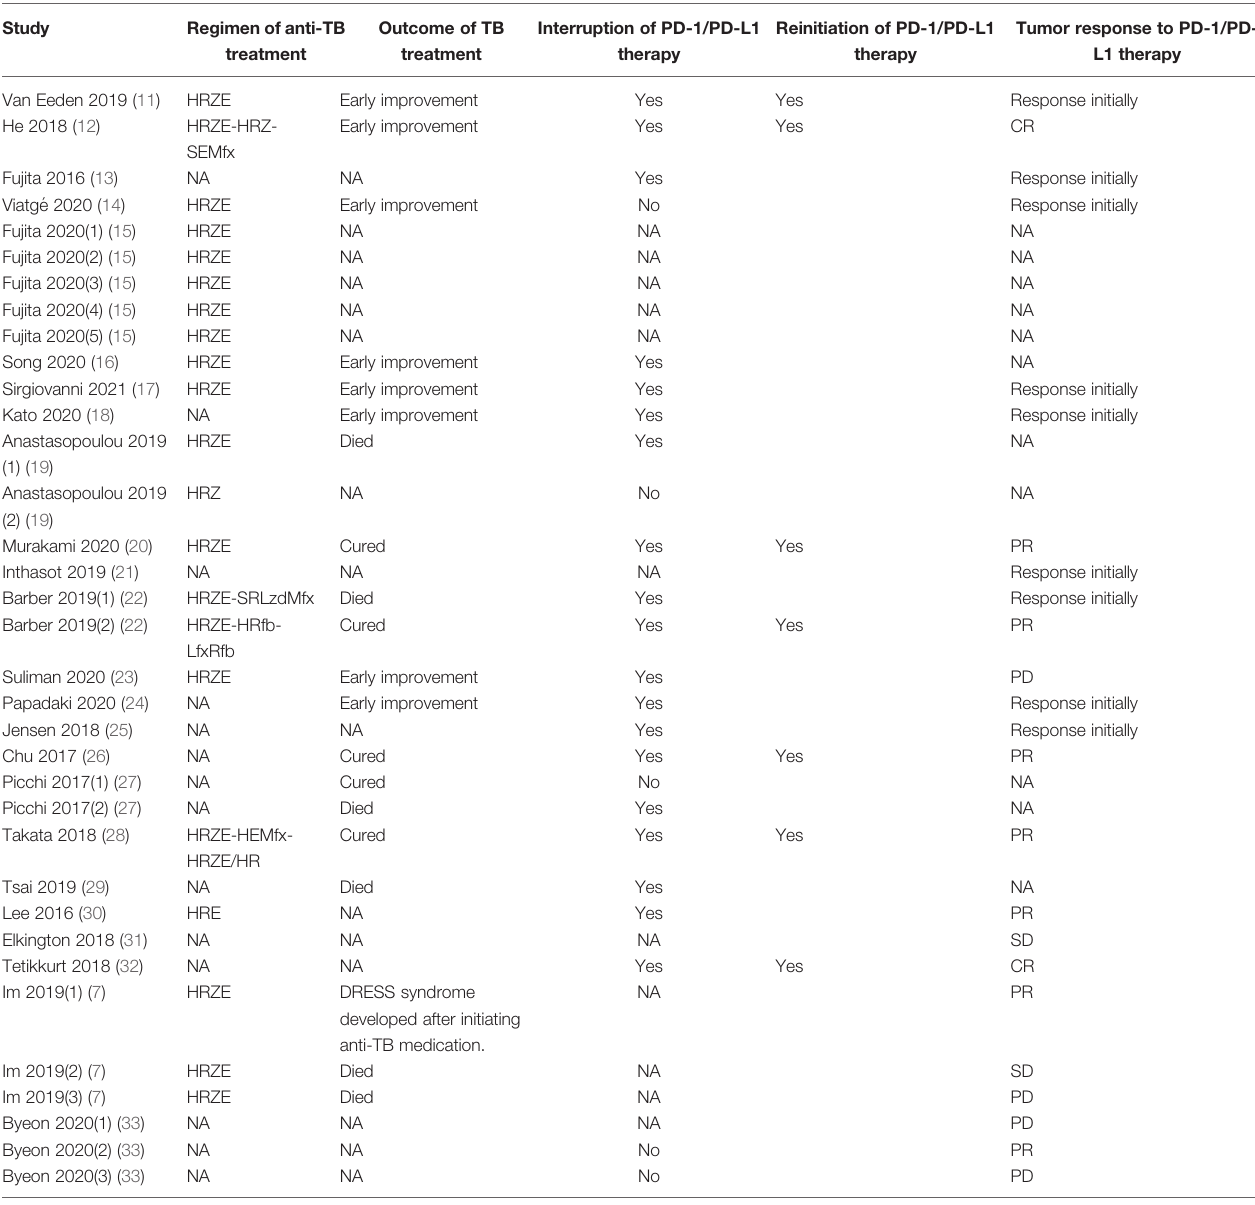
TABLE 3 | Treatment outcomes of TB patients with PD-1/PD-L1